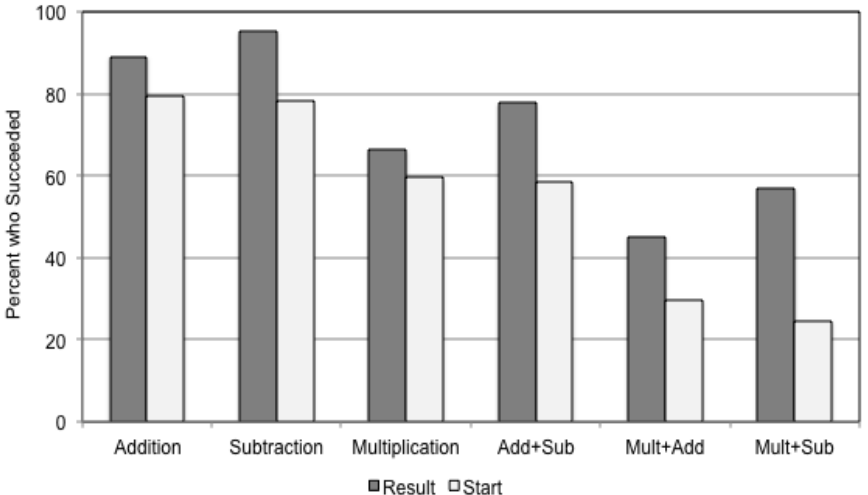
Figure 2. Percent of participants who succeeded on the story-writing task for each operation or operation combination and each position of the